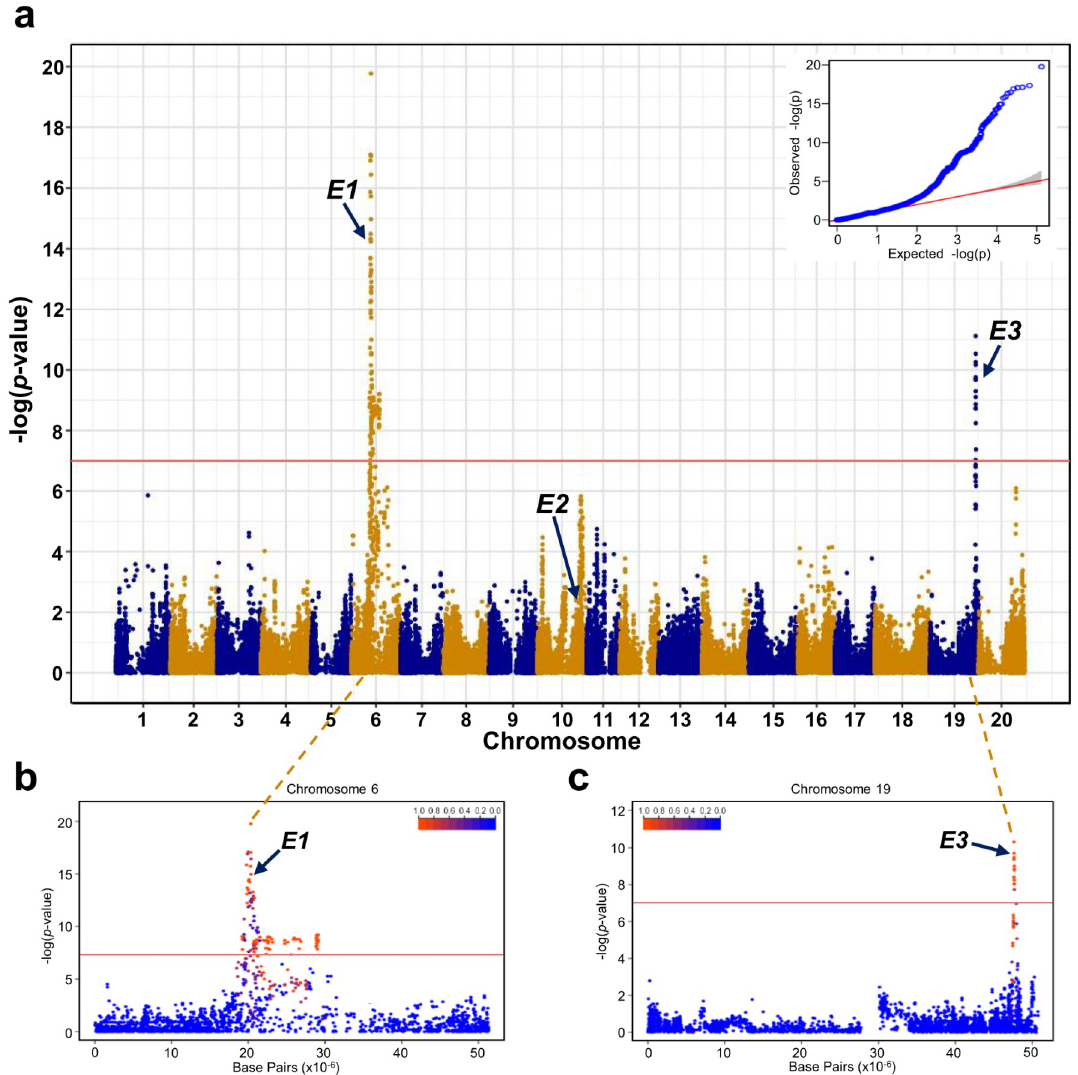
Fig 2. Manhattan plot for the DTF trait of soybean accessions. a. Manhattan plot of all 20 chromosomes. b. Manhattan plot of chromosome 6 harboring the E1 gene. c. Manhattan plot of chromosome 19 harboring the E3 gene. Red horizontal lines indicate the statistically significant cut-off of − log( p -value) = 7.